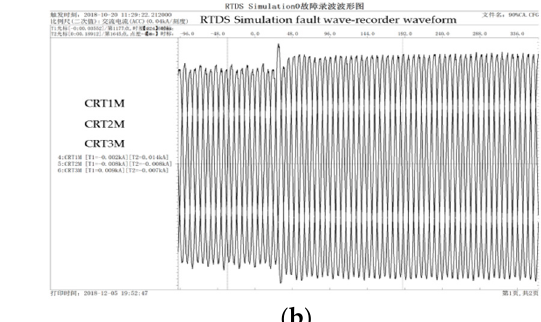
Figure 18. ( a ) Waveforms of d -axis output current. ( b ) Waveforms of q -axis output current.